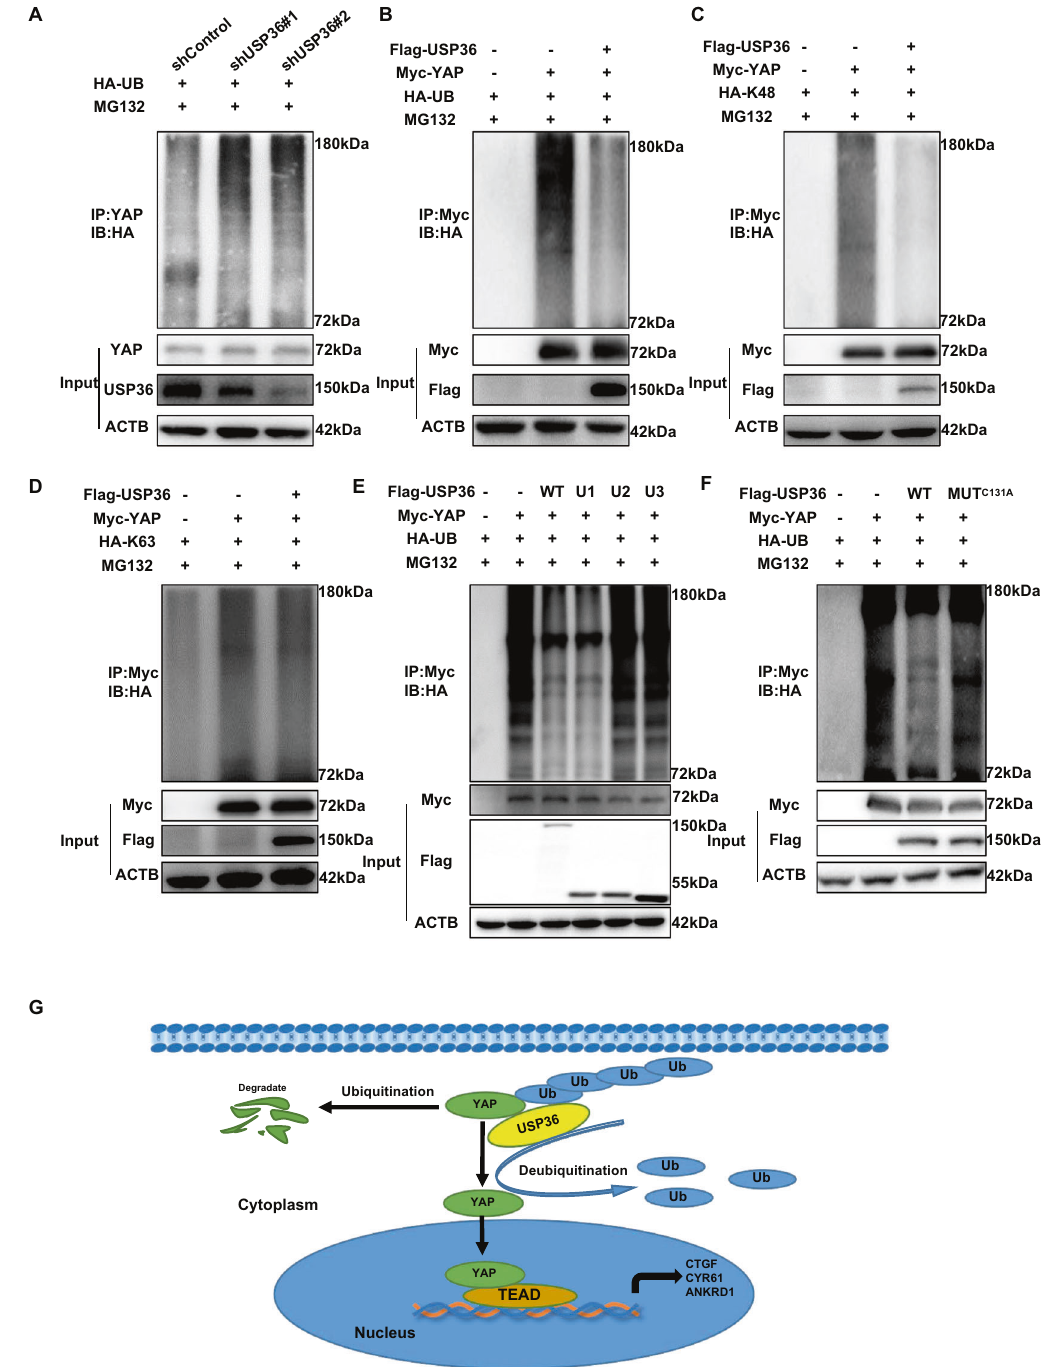
Fig. 6 USP36 modulates YAP stability in a ubiquitination-dependent manner. A The ubiquitination assay was performed with shUSP36 in ECA109 cells. After 48 h, the cells were treated with MG132 (20 µM) for 6 h. The ubiquitination assay demonstrated that depletion of USP36 promoted endogenous YAP total poly-ubiquitination in ECA109 cells. B – D HEK293 cells were co-transfected with YAP and USP36 constructs as indicated. After 48 h, the cells were treated with MG132 (20 µM) for 6 h. Global ubiquitination ( B ) K48- and K63-linked ubiquitination ( C , D ) of YAP were measured by ubiquitination assay. The ubiquitination assay demonstrated that USP36 inhibited YAP total poly-ubiquitination and K48-linked ubiquitination in HEK293 cells, while had little effect on YAP K63-linked ubiquitination. E Global ubiquitination of YAP in HEK293 cells transfected with WT or USP36 mutants was measured by ubiquitination assay. After 48 h, the cells were treated with MG132 (20 µM) for 6 h. The USP domain was essential for USP36 to regulate ubiquitination of YAP. F Global ubiquitination of YAP in HEK293 cells transfected with WT or USP36 mutant (C131A) was measured by ubiquitination assay. After 48 h, the cells were treated with MG132 (20 µM) for 6 h. The C131A mutation of USP36 impaired its ubiquitination activity and reduced the ability of USP36 to inhibit total YAP poly-ubiquitination in HEK293 cells. G USP36 associated with YAP and inhibited YAP K48-linked ubiquitination and degradation in ESCC cells, which promoted the activation of the Hippo/YAP axis and ESCC cancer